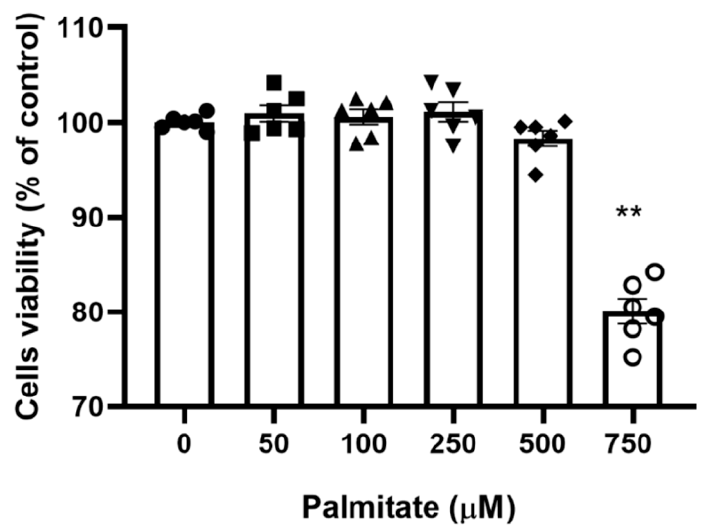
Figure 1. C2C12 myotubes viability with increasing concentration of palmitate. C2C12 myotubes were treated with increasing palmitate concentrations from 0 (control) to 750 µ M; ( n = 6). ** Significantly different from control ( p < 0.01). Data represent mean ± SEM of 6 individual experiments in each study group.